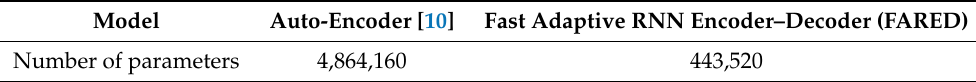
Table 2. Comparison of the number of the